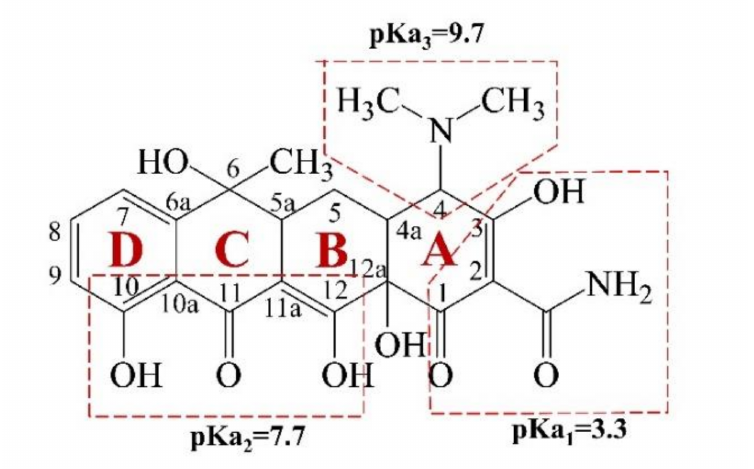
Figure 5. Chemical structures and pKa values of